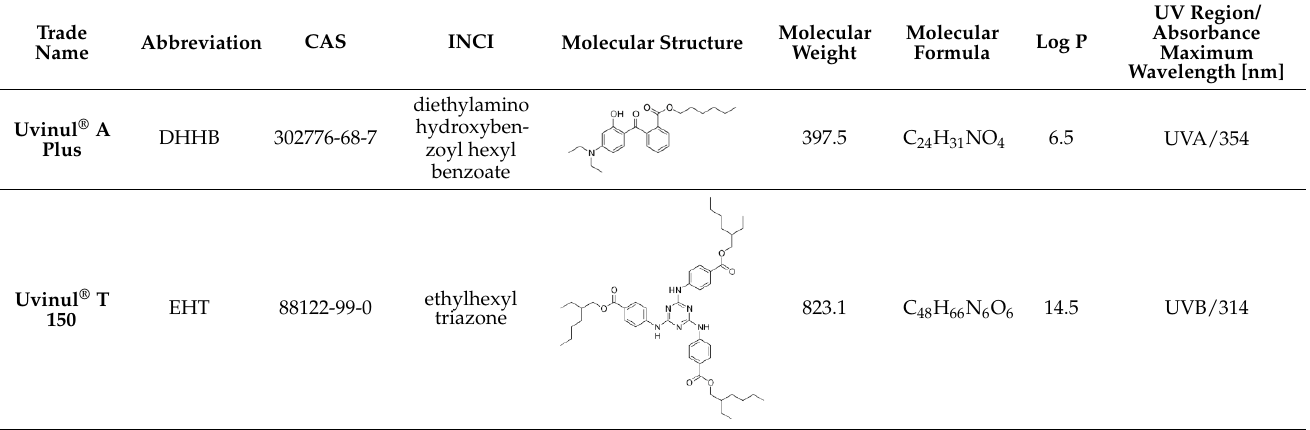
Table 4. Main physical properties and structure of DHHB and EHT molecules.